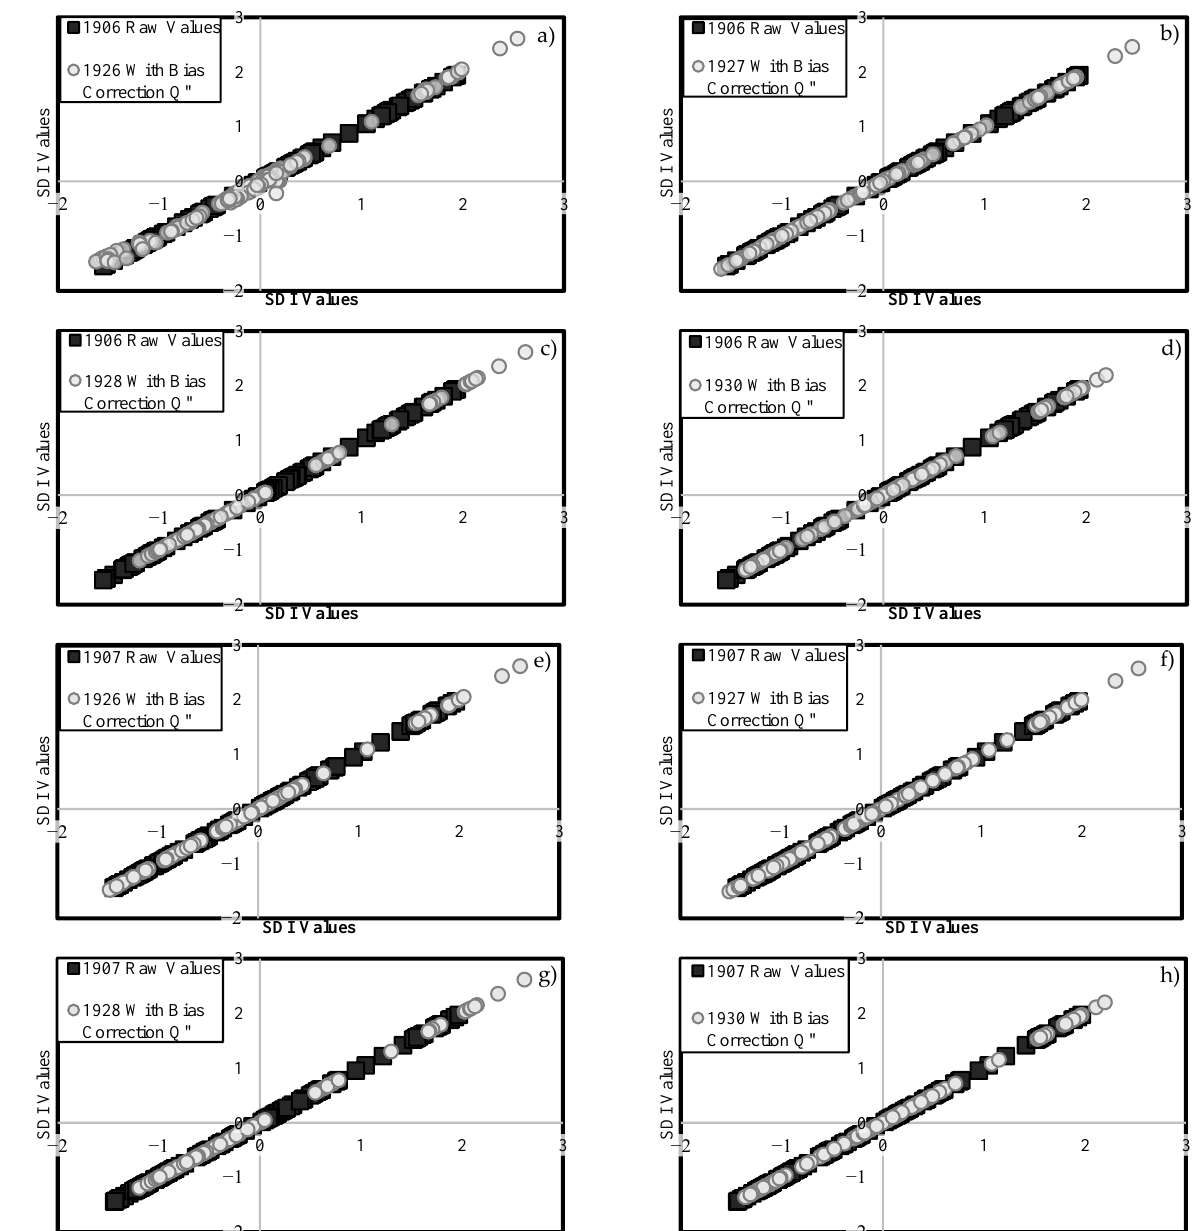
Figure 9. Scatter plots of SDI-12 values. ( a ) 1926 and 1906, ( b ) 1927 and 1906, ( c ) 1928 and 1906, ( d ) 1930 and 1906, ( e ) 1926 and 1907, ( f ) 1927 and 1907, ( g ) 1928 and 1907, ( h ) 1930 and 1907. While the 2008 to 2009 water year stood out as the driest period for both of the target stations, it was seen that the SDI values were well estimated by stations D19A026, D19A027 and D19A030. The SDI values obtained with the data of station D19A028 transferred to the target station could not adequately predict the driest period. Examining the calculated SDI values and transfer results of the 1906 and 1907 stations with the original data, the wet periods seen in the 2004 to 2005 water years were well represented by all stations. The original values of the target stations and the frequency graphs of the SDI values created with the transferred data are shown in Figure 11. It is possible to point out the mild drought period as the most striking period in all the